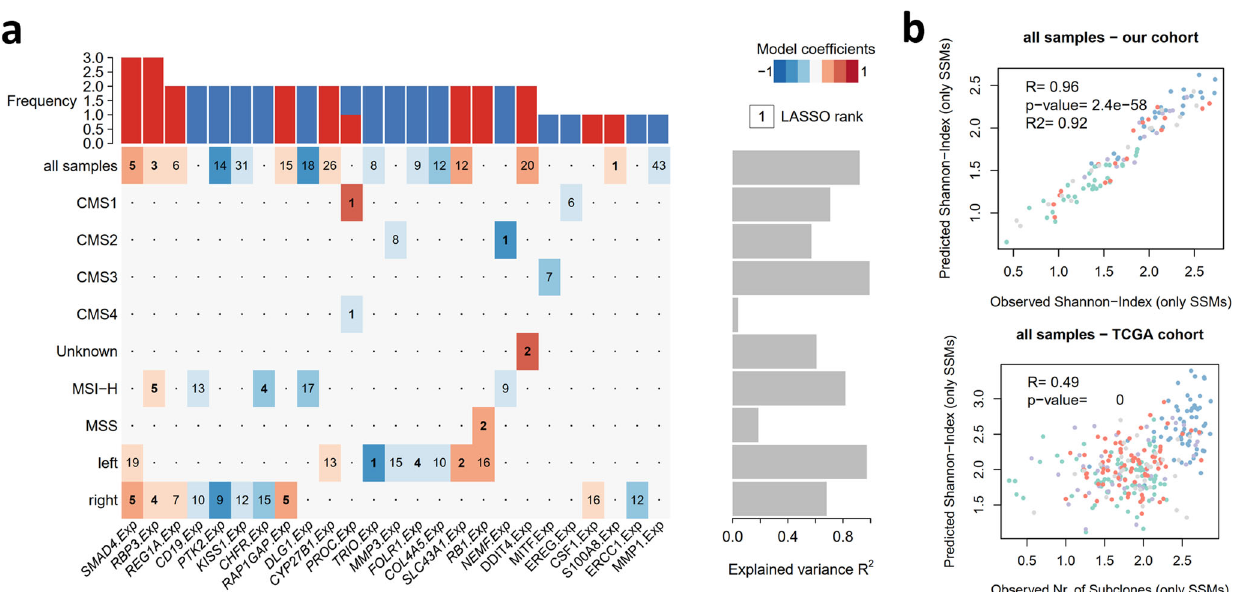
Fig. 4 Transcriptional biomarker signatures for genetic ITH. a Heatmap of cancer-related genes whose expression levels are associated with genetic ITH levels (only SSMs) in CRC samples depicted by a LASSO penalized model. Each line represents an independent analysis applied to the CRC samples segregated according to CMS subtypes (all samples n = 112; CMS1 n = 27; CMS2 n = 36; CMS3 n = 12; CMS4 n = 19), MSI status (MSS n = 59; MSI-H n = 53) or primary tumor location (right n = 68; left n = 33). LASSO-selected coef fi cients are colored according to the effect of each standardized covariate in the optimal model. The numbers on each tile denote the order in which variables are included indicating their relative importance. The top bar plot indicates the frequency at which each driver-gene mutation occurs in the ITH fi tted model. The right bar plot shows the explained variance. b Comparison between observed and predicted genetic ITH levels (only SSMs) for all samples in our cohort and in